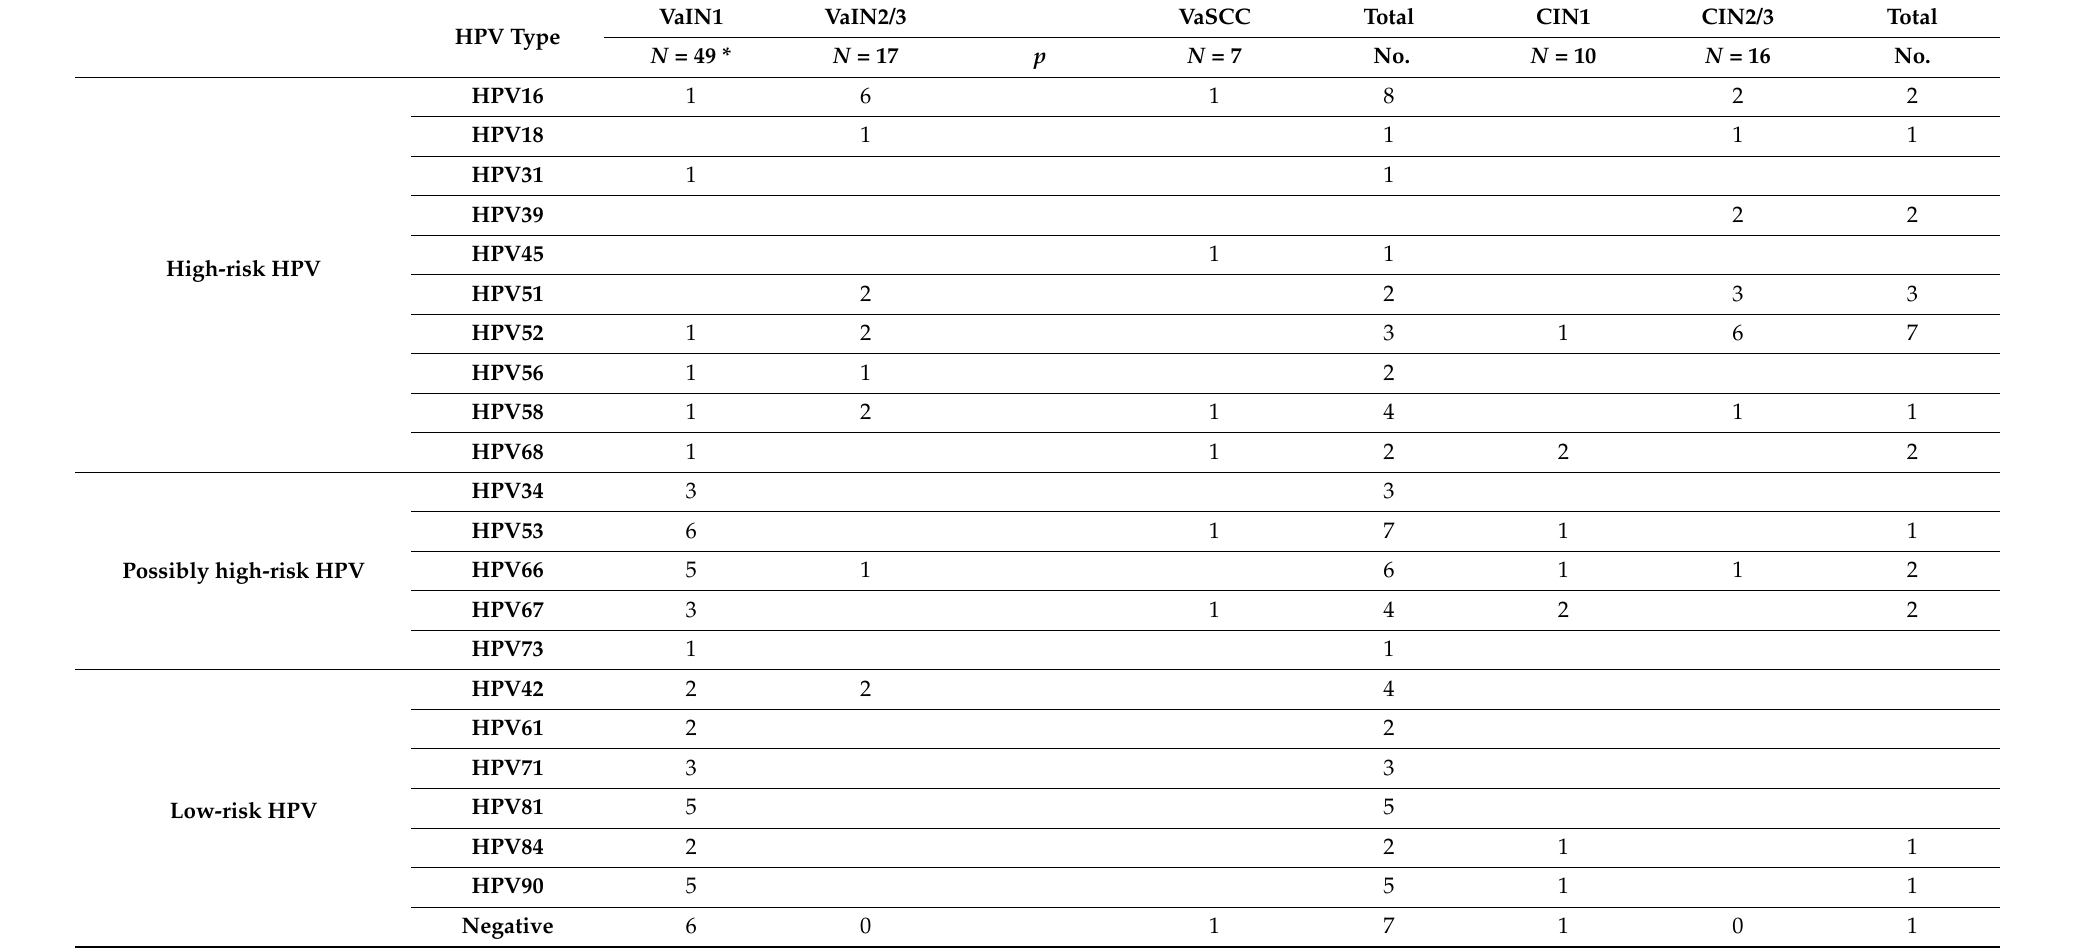
Table 5. Identified HPV type in a histological tissue of VaIN, VaSCC and